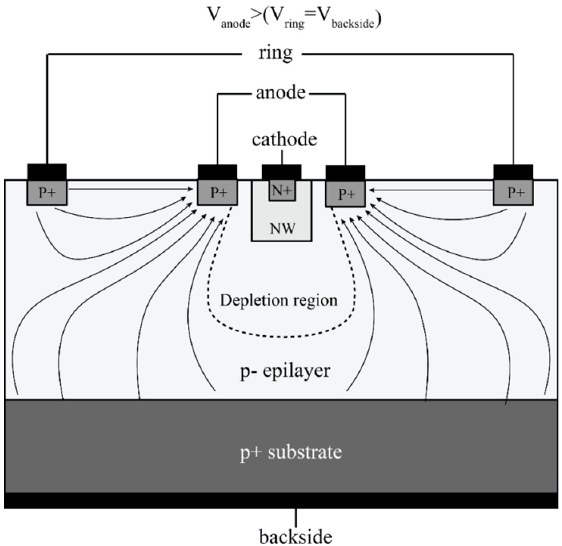
Figure 1. Schematic cross-section of the current-assisted single-photon avalanche diode (CASPAD) (not to scale) with the p-n junction in the middle and a current assistance “ring” to guide the photo-